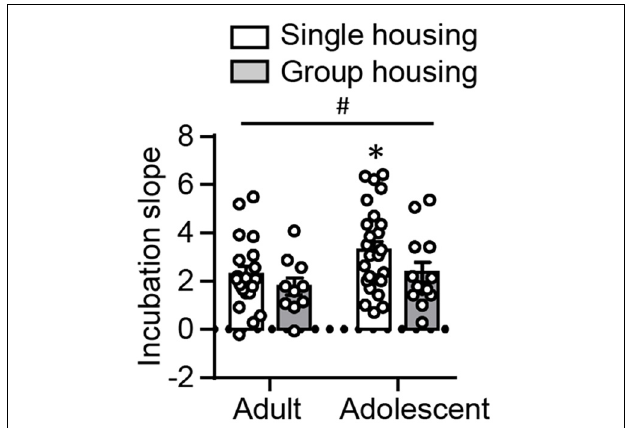
FIGURE 4 | Comparison of incubation slopes following adult-onset and adolescent-onset oxycodone self-administration. Data are mean ± SEM of calculated incubation slopes using the data from the day 1 relapse test, and the first 30 min of the day 15 relapse test. Incubation slope = (active lever presses on abstinence day 15 − active lever presses on abstinence day 1)/(15 − 1). # Main effect of Age; *Different from Adult, p < 0.05. n =